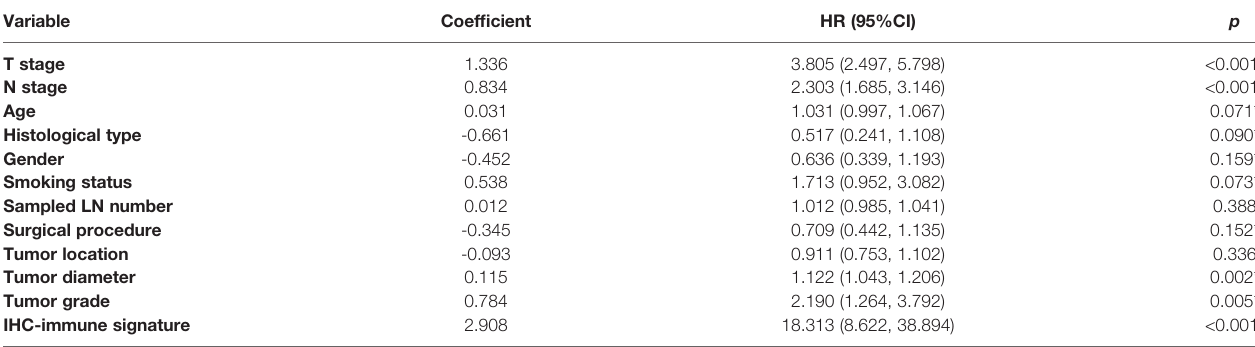
TABLE 2 | Univariate analyses for the potential prognostic predictors.